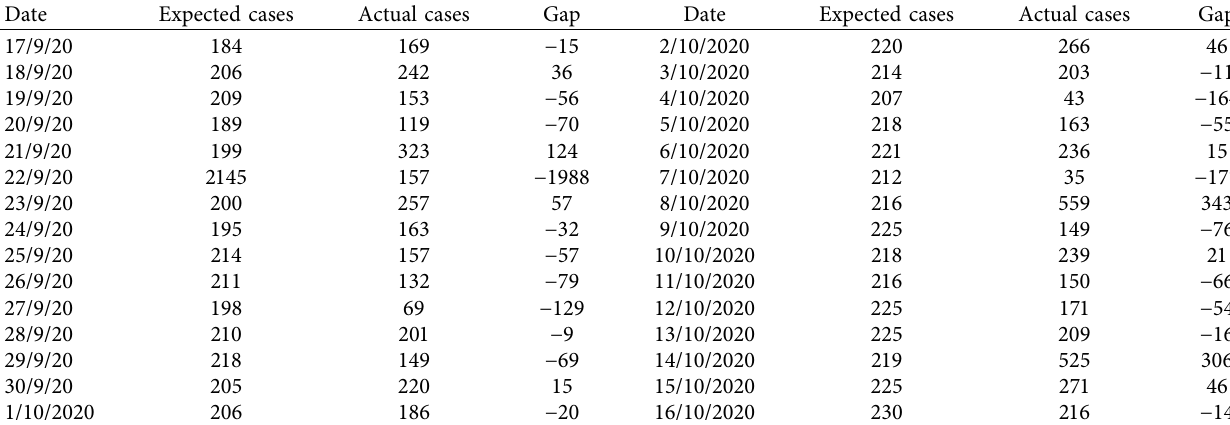
Table 12: The deviation between the actual and forecasted values of the daily confirmed COVID-19 cases in Central Africa for the period between 17/9/2020–16/10/2020.